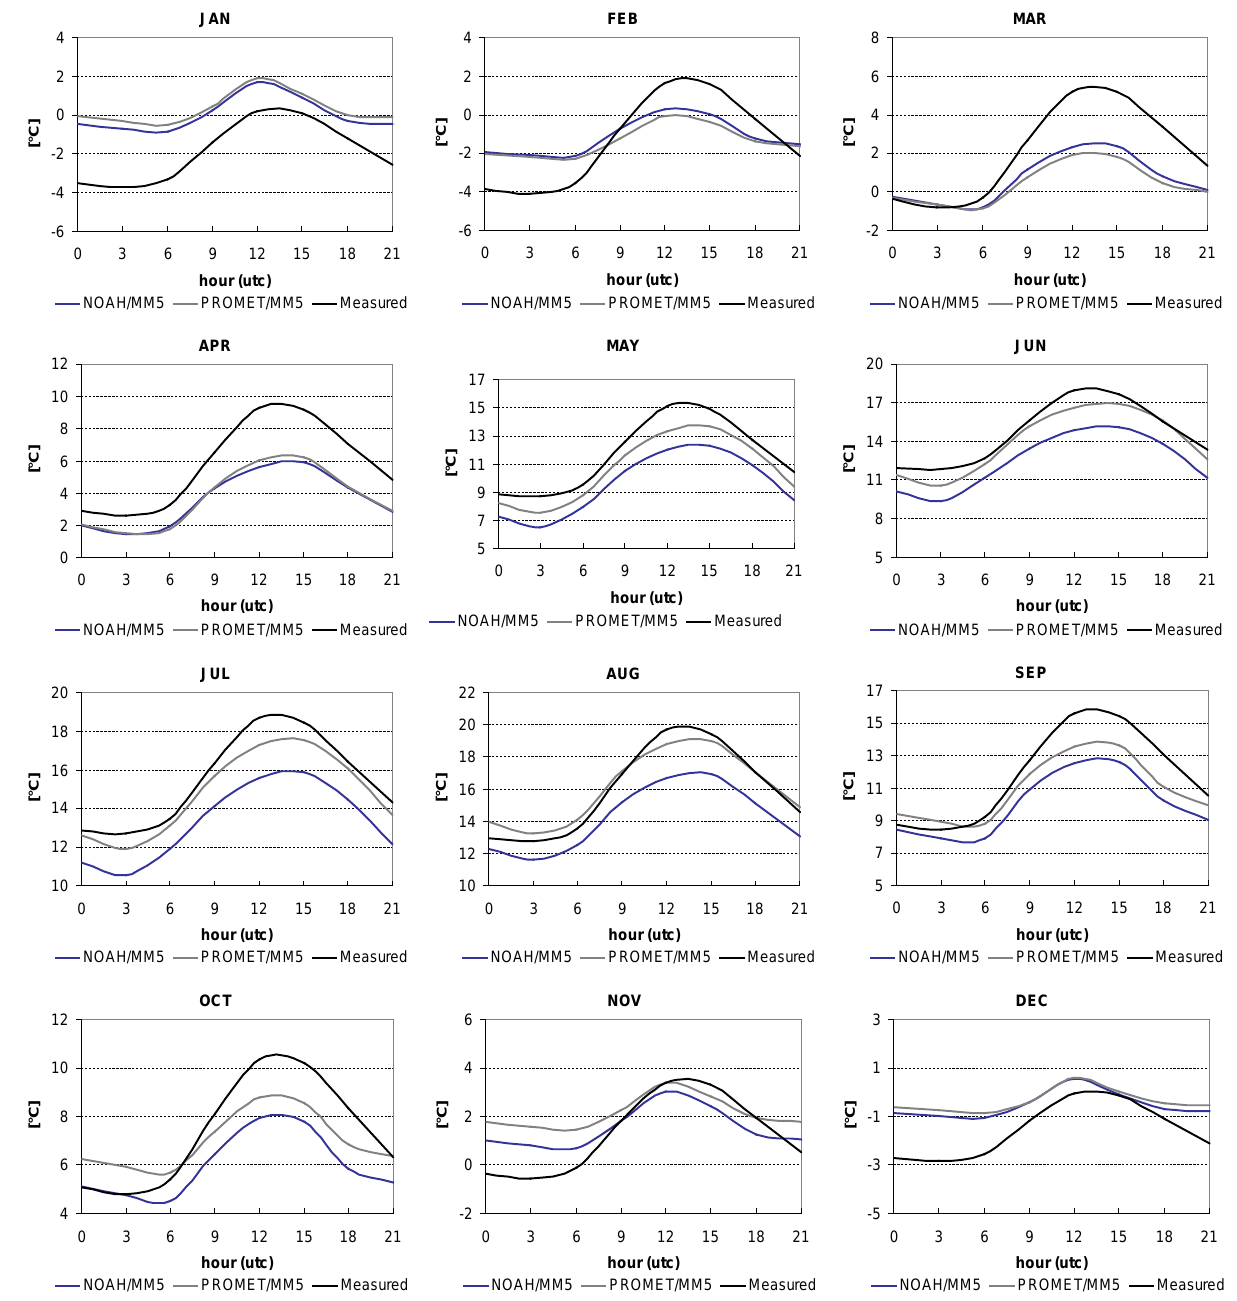
Figure 7: Monthly mean diurnal cycle (1996-1999) of the near surface air temperature (3- Fig. 7. Monthly mean diurnal cycle (1996–1999) of the near-surface air temperature (3-hourly) for the Upper Danube catchment. hourly) for the Upper-Danube catchment. summer months. The lower values in the monthly precipita- tion from May to September in the results of PROMET/MM5 are due to the 20 % decrease in the simulation of convec- tive precipitation, versus a 9 % decrease in